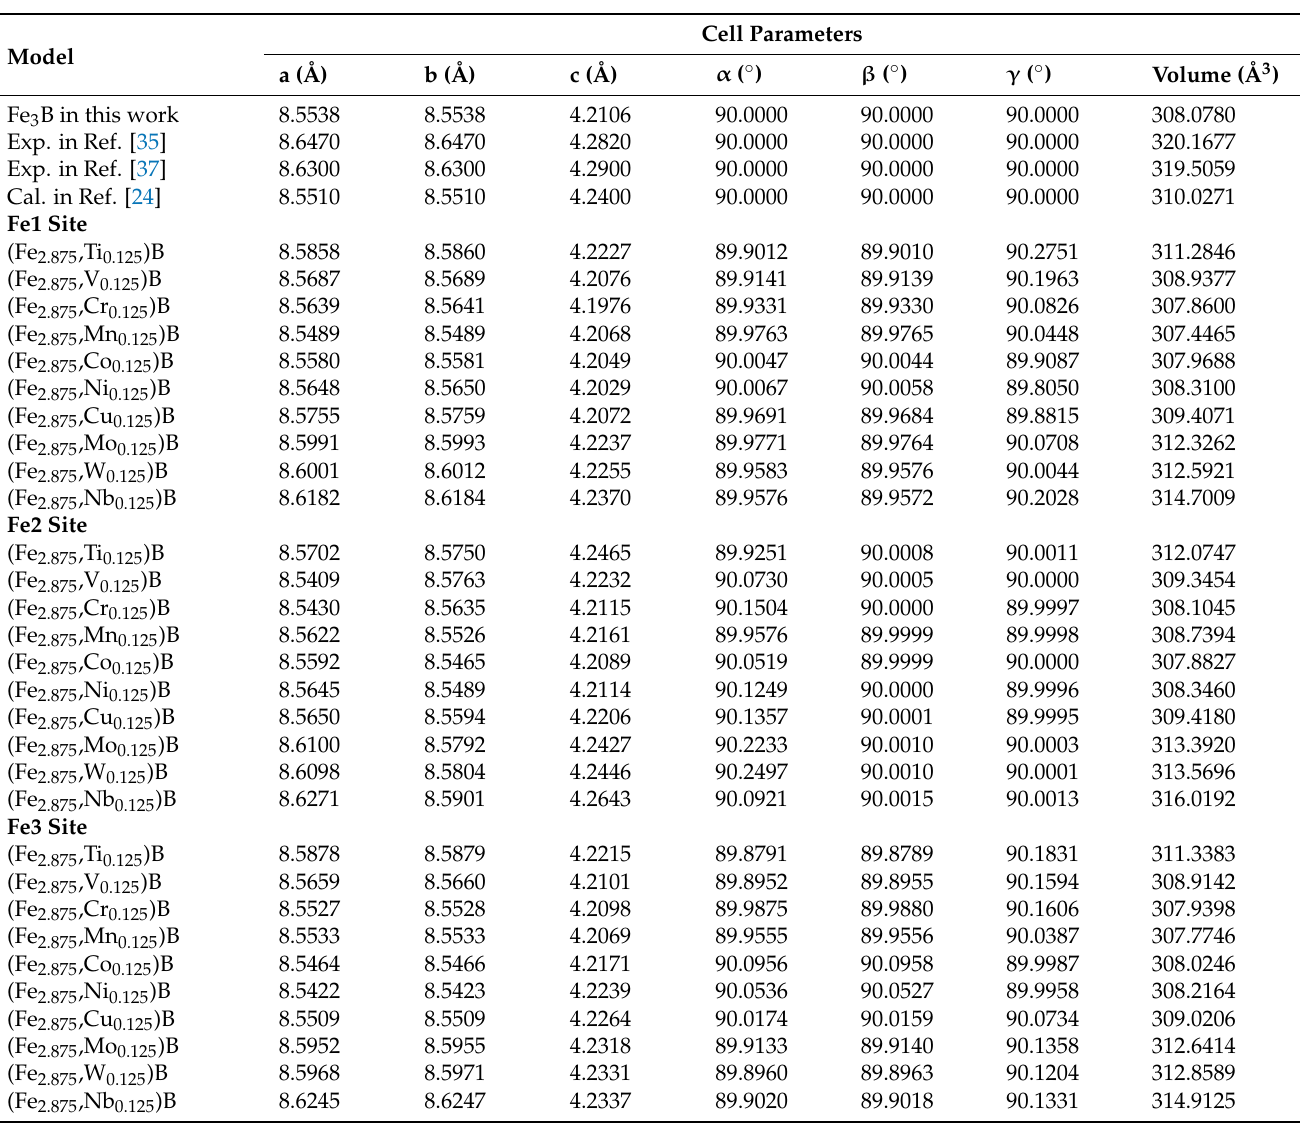
Figure 3. ( a ) Polycrystalline XRD patterns of ( a ) Fe 3 B and ( b ) Fe 2 B. Table 1. Cell parameters of Ni 3 P-type Fe 3 B and its alloyed